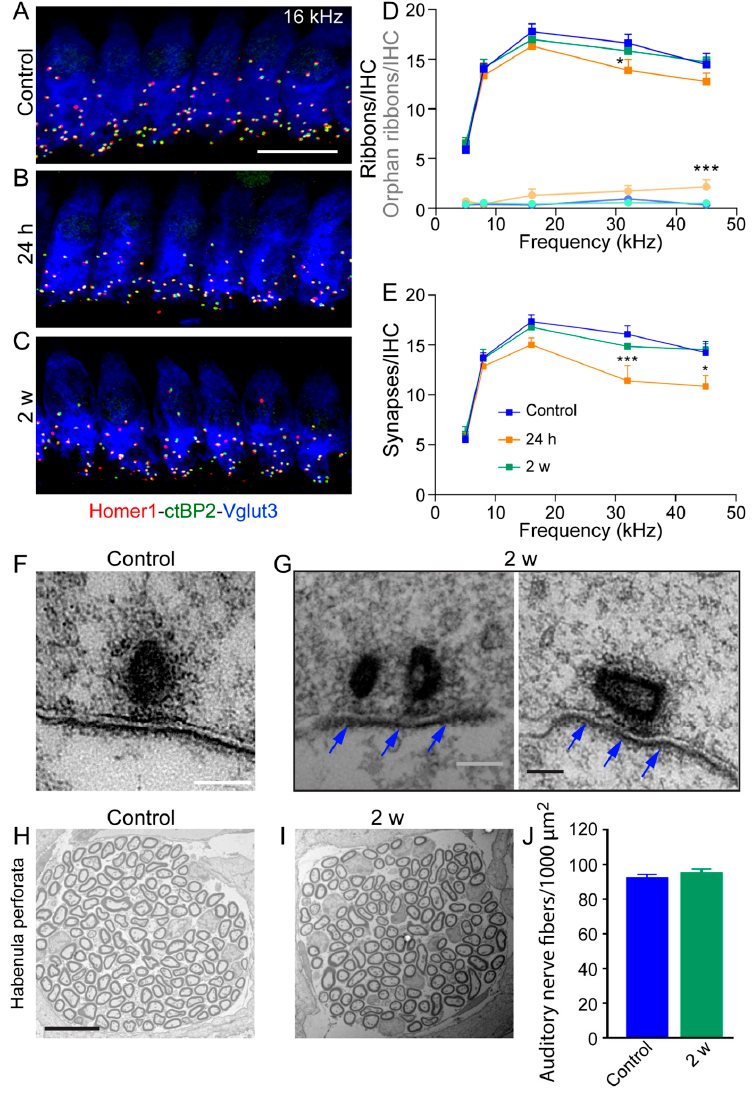
Figure 5. Reversible and moderate loss of IHC ribbon synapses. ( A – C ): Maximum intensity projections of confocal z-stacks of inner hair cells (IHCs) immunolabeled with anti-Vglut3 (blue), anti-Homer1 (red) and anti-CtBP2 (green) in the mid-cochlear region from control mice ( A ), noise-exposed mice at 24 h ( B ), and 2 weeks after ( C ). Scale bar = 10 µ m. ( D ): Quantifications of ribbons total (all CtBP2 puncta, blue, green and orange lines) and orphan ribbons (unpaired CtBP2 puncta, light blue, green and orange lines) per IHC along the tonotopic axis of the cochleae from control (blue), and impulse noise-exposed mice at 24 h (orange) and 2 weeks (green) after exposure. Two-way ANOVA test was followed by Dunnett’s multiple comparison: * p ≤ 0.05, time after noise exposure vs. before. All data are expressed as mean ± SEM ( n = 7–8 cochleae for per time point). ( E ): Quantifications of synapses (paired CtBP2-Homer1 puncta). Two-way ANOVA test was followed by Dunnett’s multiple comparison: * p ≤ 0.05, *** p ≤ 0.001, time after noise exposure vs. before. All data are expressed as mean ± SEM ( n = 7–8 cochleae for per time point). ( F , G ): TEM images of ribbon synapses from the cochlear regions coding 16–25 kHz from control ( F ), and 2 weeks ( G ) after exposure. Note, at 2 weeks after exposure ( G ), some immature synapse morphology: a double presynaptic ribbon or a disoriented ribbon. Scale bars = 200 µ m. ( H , I ): Representative transmission electron micrographs showing the auditory nerve fibers in semi-thin sections of the habenula perforata in the cochlear region coding 16–25 kHz from control ( H ), and 2 weeks ( I ) after exposure. ( J ): Quantitative assessment of auditory nerve fibers density in control (blue) and 2 weeks (red) after exposure ( n = 200 and 400 individual fibers per group and from 4–5 cochleae per each condition). All data are expressed as mean ± SEM, one-way ANOVA test was followed by Dunn’s